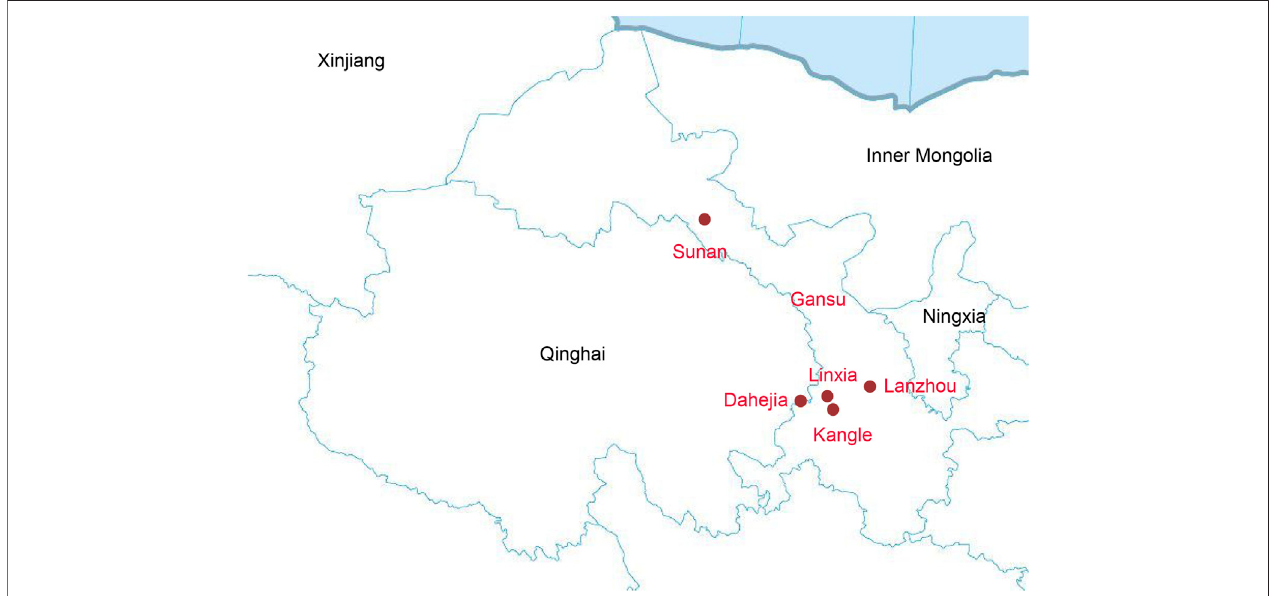
FIGURE 1 | The geographical map of our samples